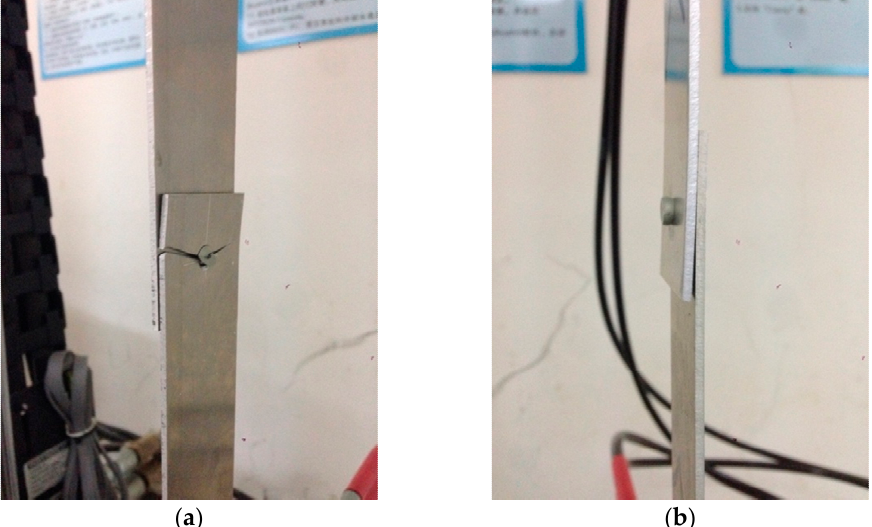
Figure 15. High-cycle and low-cycle fatigue test results of riveted lap joints: ( a ) plate fractures with high-cycle fatigue failure; ( b ) rivet fracture with low-cycle fatigue failure.